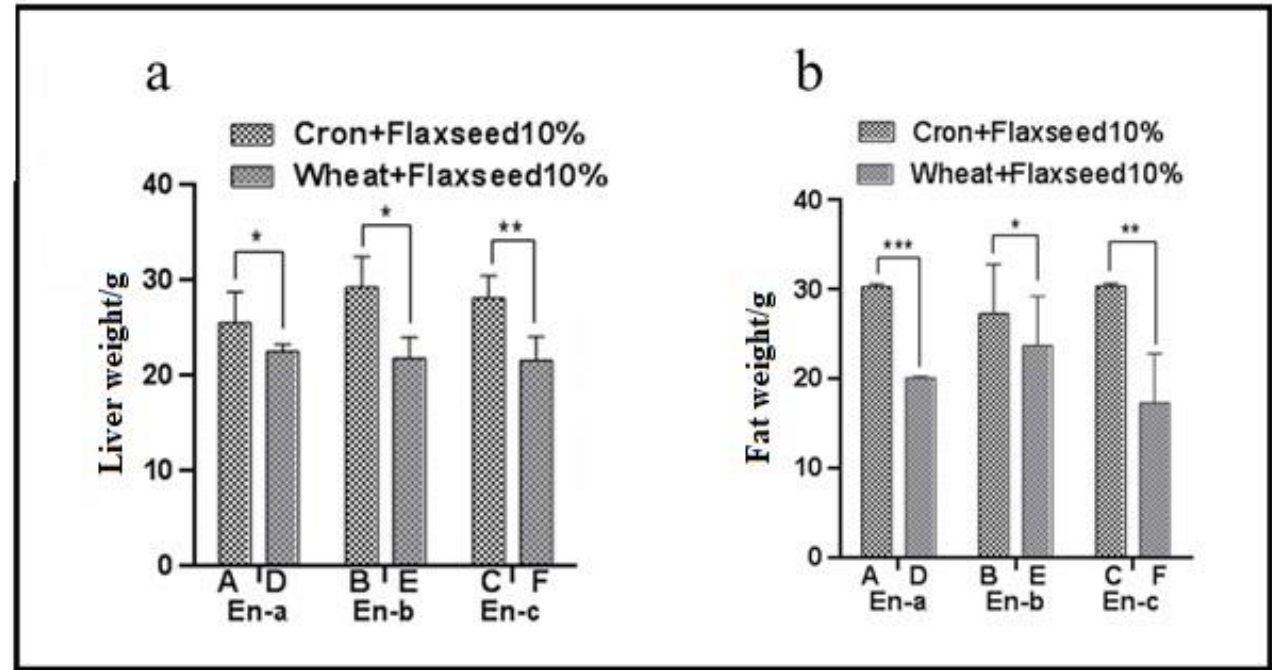
Figure 1. Effect of corn and wheat diet supplemented with flaxseed and enzyme on liver and fat weight in laying hens. Corn and wheat diets were formulated with 10% flaxseed and indicated as Treatments A, B, C and D, E, F, respectively; The two diets were treated, respectively, with three different multi-carbohydrase enzymes, and indicated as enzyme-a, enzyme-b, and enzyme-c. ( a ) liver and ( b ) fat weight of laying hens were calculated after feeding with corn and wheat diets supplemented with enzymes for 28 days Data are expressed as mean ± SEM. * p < 0.05, ** p < 0.01, and *** p < 0.001.